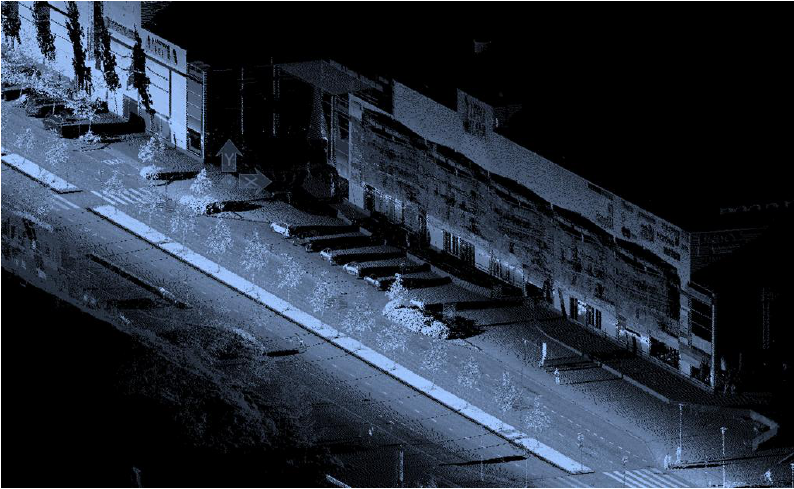
Figure 12. The ROAMER test data obtained on the FGI MLS performance test